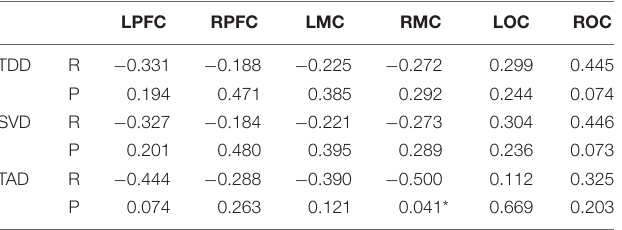
TABLE 2 | Correlation and significance between WA value of brain region and